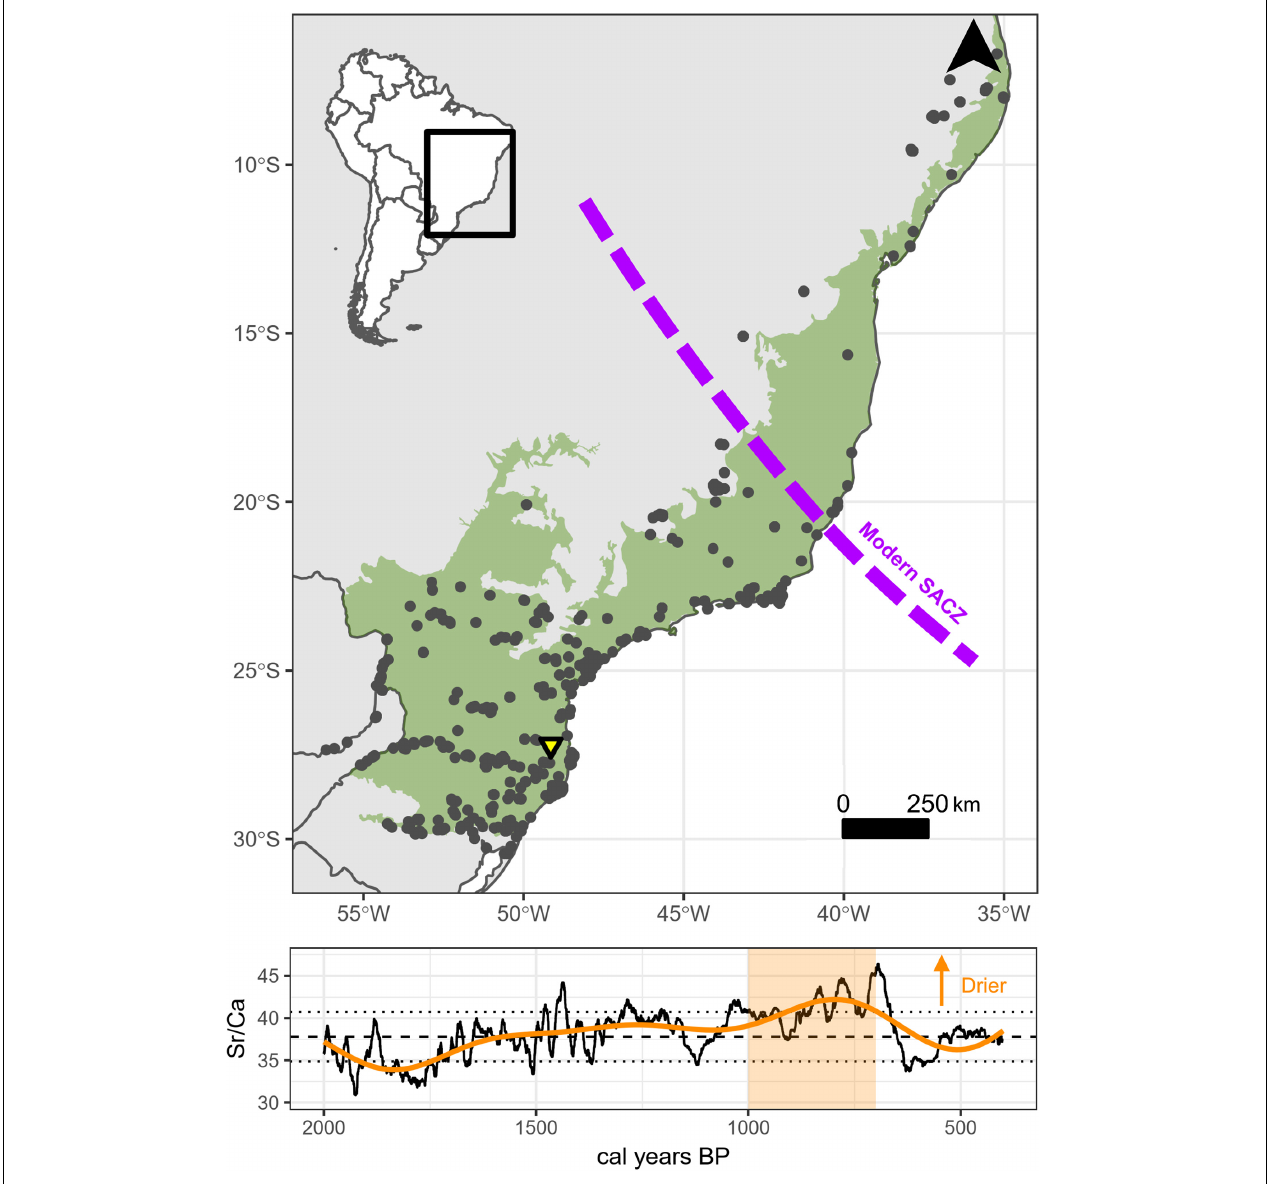
FIGURE 1 | Archaeological and palaeoclimatic overview. Top: locations of radiocarbon dated archaeological sites (grey points) and Botuverá cave speleothem (yellow triangle in the Atlantic Forest (green). Bottom: Botuverá hydroclimatic proxy (Sr/Ca: black line) and smoothed fit (orange line) for 2,000–400 cal BP, with record mean and standard deviations. MCA period highlighted by